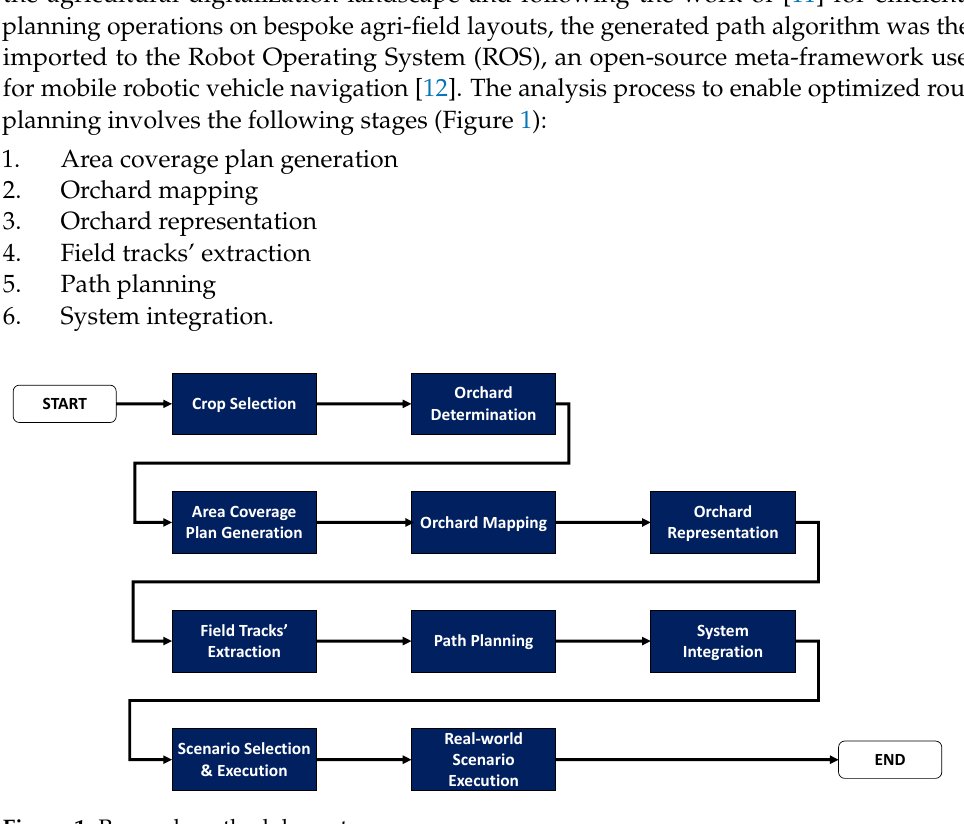
Figure 1. Research methodology steps.